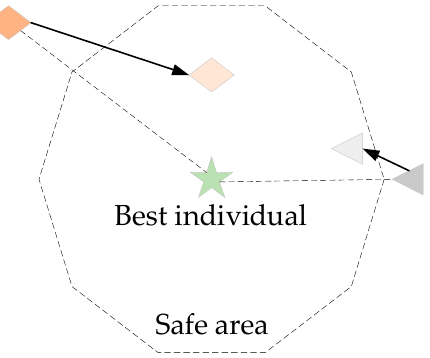
Figure 5. Schematic diagram of the punishment mechanism for